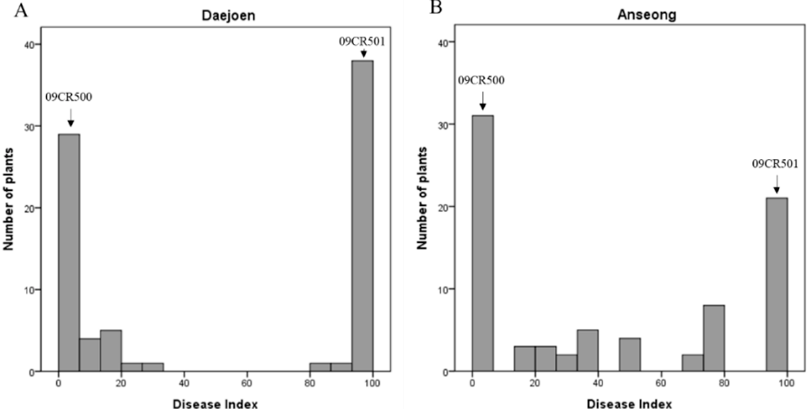
Figure 2. Distribution of mean disease index (DI) investigated over 2 years for clubroot disease in ‘09CR-DH’ population in ( A ) Daejeon and ( B ) Anseong. Table 1. Genetic analysis of clubroot resistance associated with “09CR500” in the doubled haploid (DH) population against the P. brassicae pathotype Banglim.